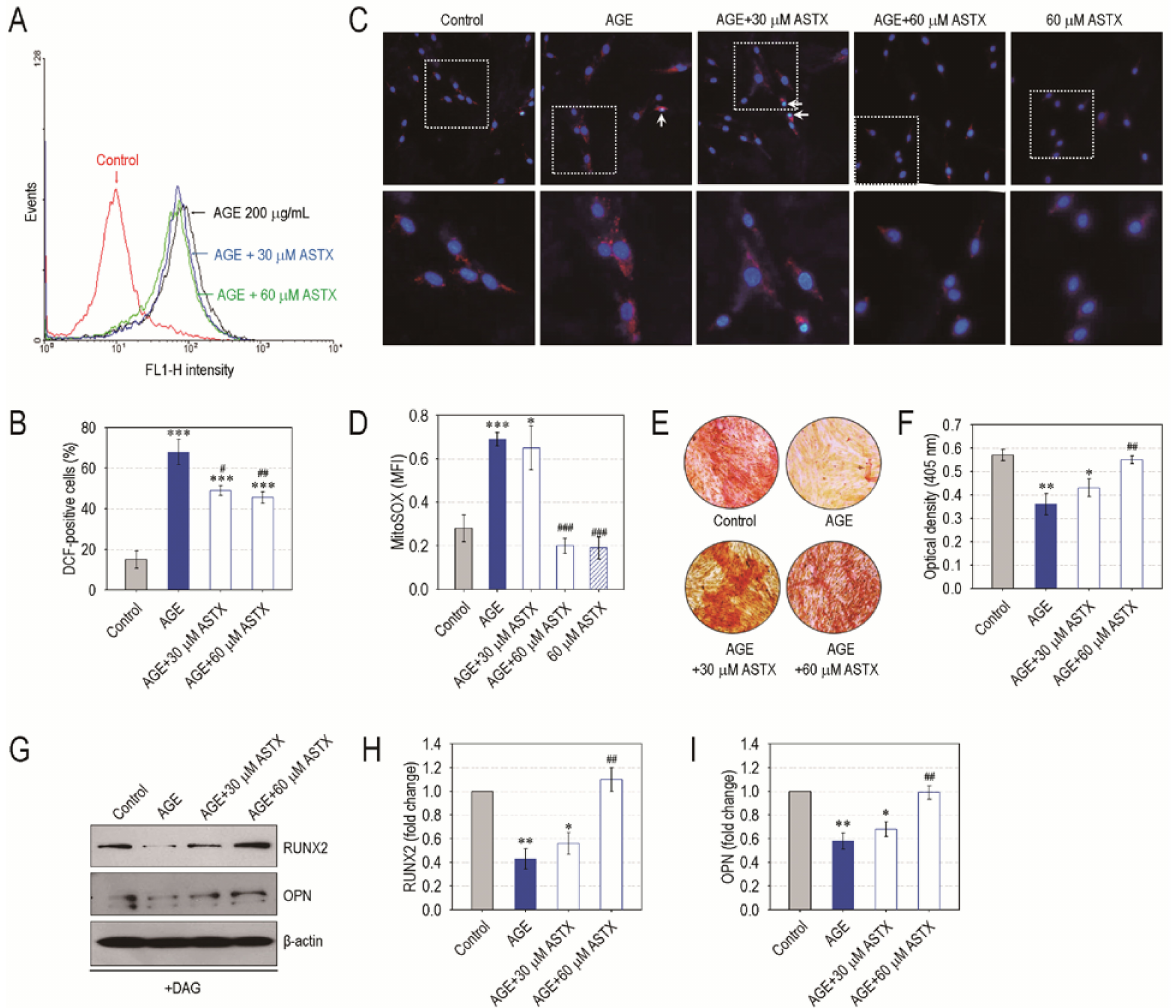
Figure 7. ASTX inhibits oxidative stress and increases mineralization in AGE-treated hPDLCs. The hPDLCs were incubated in growth medium supplemented with and without AGE (200 µ g/mL), ASTX (30 or 60 µ M), or both for 48 h. ( A ) ROS accumulation in the cells was determined by flow cytometry using DCFH-DA, and ( B ) the DCF-positive cells (%) were calculated ( n = 5). ( C ) The level of mitochondrial superoxide in the cells was determined by staining them with MitoSOX Red and DAPI, and ( D ) the MFI specific to the red dye was calculated using ImageJ software ( n = 5). Alternatively, the hPDLCs were incubated in DAG-supplemented osteogenic medium in the presence and absence of AGE, ASTX or both. ( E ) After 14 days of incubation, the cells were stained with Alizarin Red S, and ( F ) the red dye-specific optical density in the cells was determined using a microplate reader ( n = 5). ( G ) The protein levels of osteogenic markers in the cells exposed to AGE, ASTX, or both were analyzed by immunoblot assay 5 days after incubation, and the band intensities of ( H ) RUNX2 and ( I ) OPN were calculated ( n = 4). * p < 0.05, ** p < 0.01, and *** p < 0.001 vs. the untreated control hPDLCs. # p < 0.05, ## p < 0.01, and ### p < 0.001 vs. the hPDLCs exposed to AGE